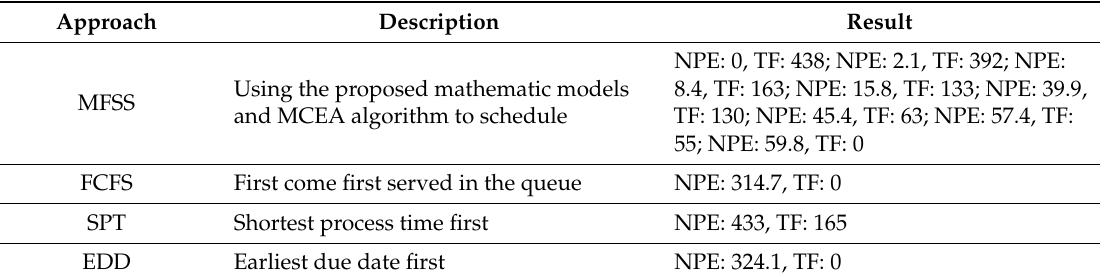
Table 7. The comparison with three scheduling approaches.